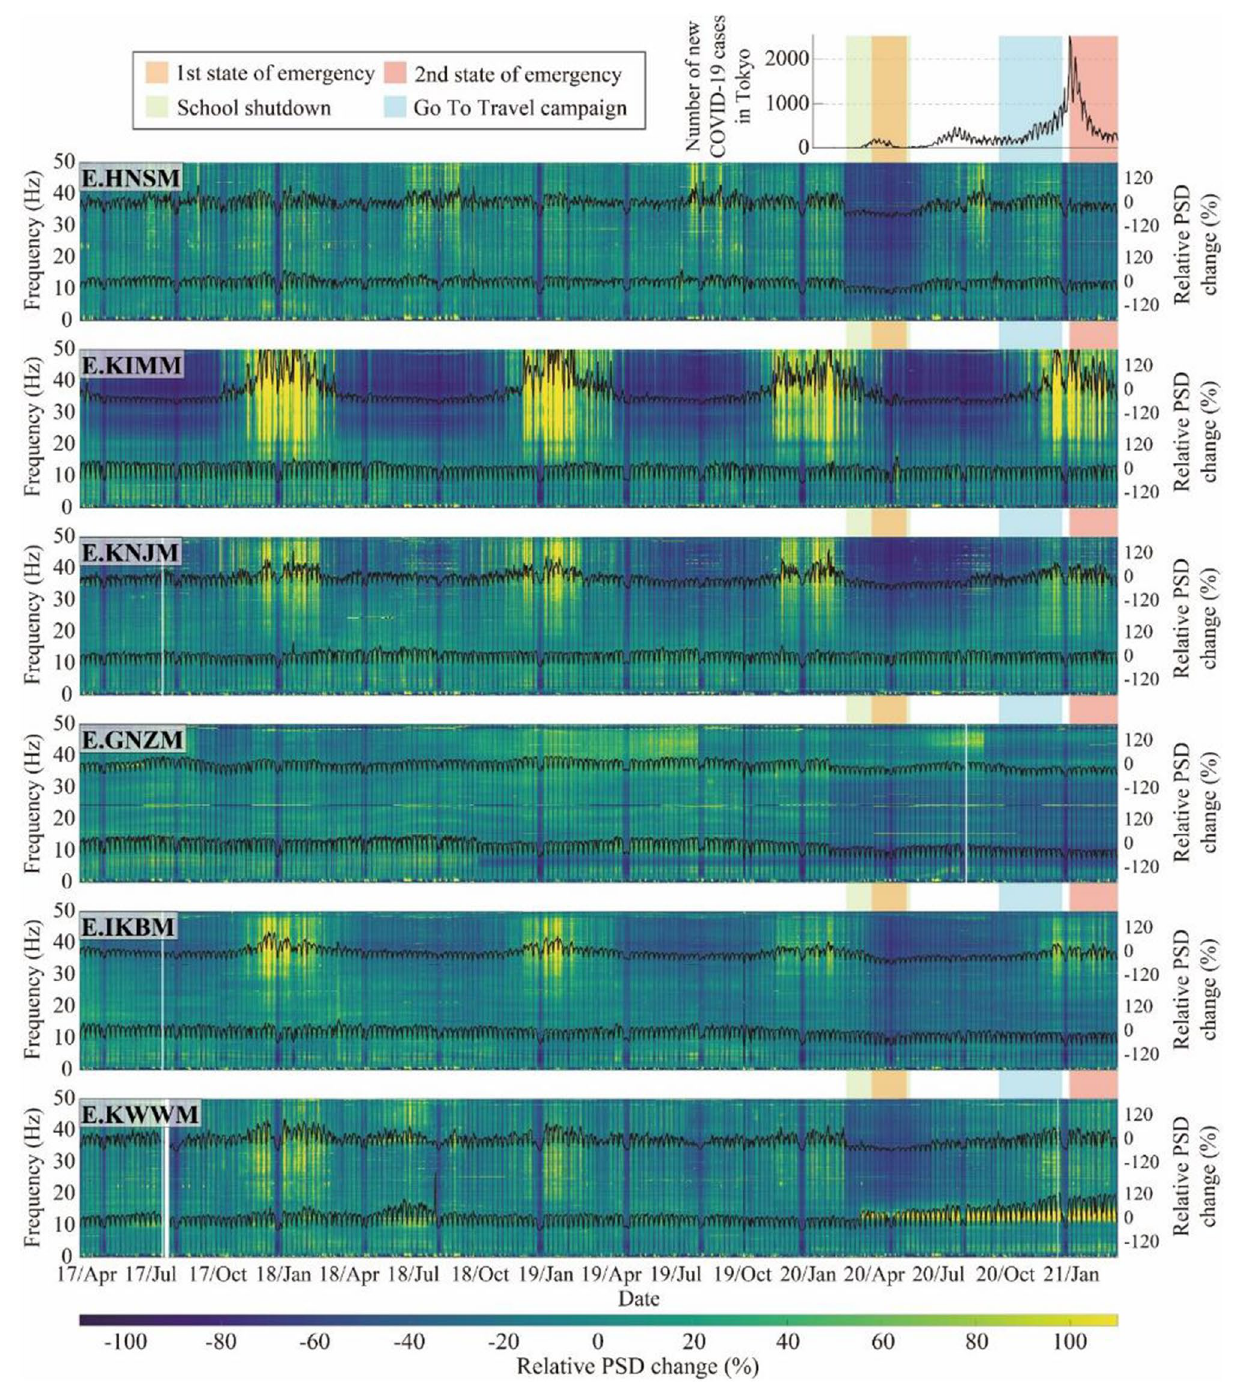
Figure 3. Time-series of the relative noise level from April 2017 to March 2021 for six stations. The background color indicates the relative noise level at each frequency. The upper and lower black solid lines in each panel represent the relative noise level of the mean value in the frequency ranges of 4–14 Hz and 20–45 Hz, respectively. The upper right figure shows the number of new COVID-19 cases in Tokyo (same as Fig. 1). The orange and pink shaded areas represent the periods of the first and second states of emergency in Tokyo, respectively; the green shaded area represents the period of school closures; and the light blue shaded area represents the period of the Go To Travel